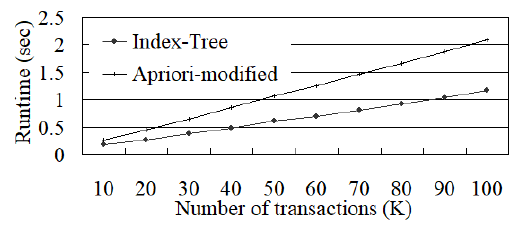
Fig. 12 Runtime vs.number of transactions ( n = 100, m = 5%, s =